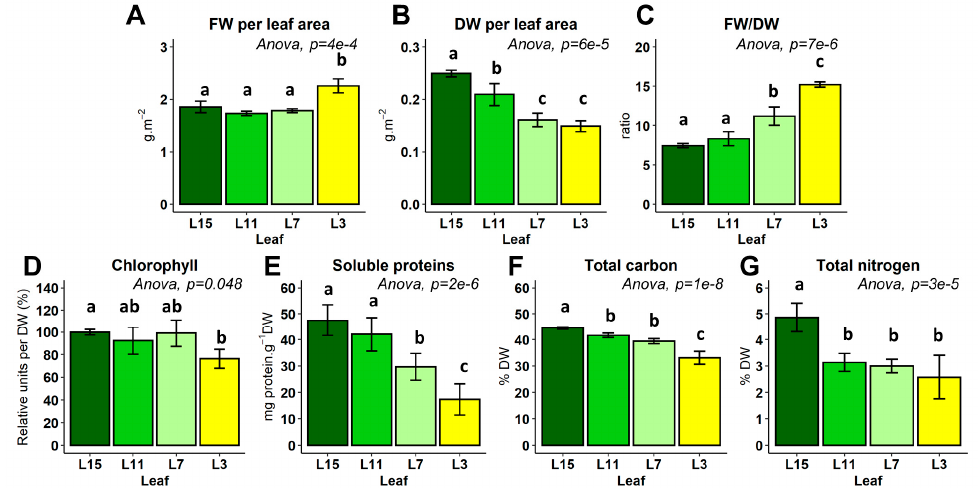
Figure 1. Physiological indicators of the sink/source status of four leaf ranks (L15, L11, L7, L3) from oilseed rape plants grown at the vegetative stage. ( A ) Fresh weight (FW) per leaf area; ( B ) Dry weight (DW) per leaf area; ( C ) Ratio of fresh weight over dry weight; ( D ) Relative chlorophyll content; ( E ) Soluble protein content; ( F ) Total carbon content; ( G ) Total nitrogen content. Plants were grown for 60 days after sowing and developed 16 leaf ranks annotated from the bottom to the top, accordingly (L1 to L16) and the two oldest leaves had already fallen off (L1 and L2). Values are the mean ± SD of 3–5 independent biological replicates. Different letters indicate groups of mean values that are significantly different between the different leaf ranks (ANOVA-Tukey HSD, p -value < 0.05).